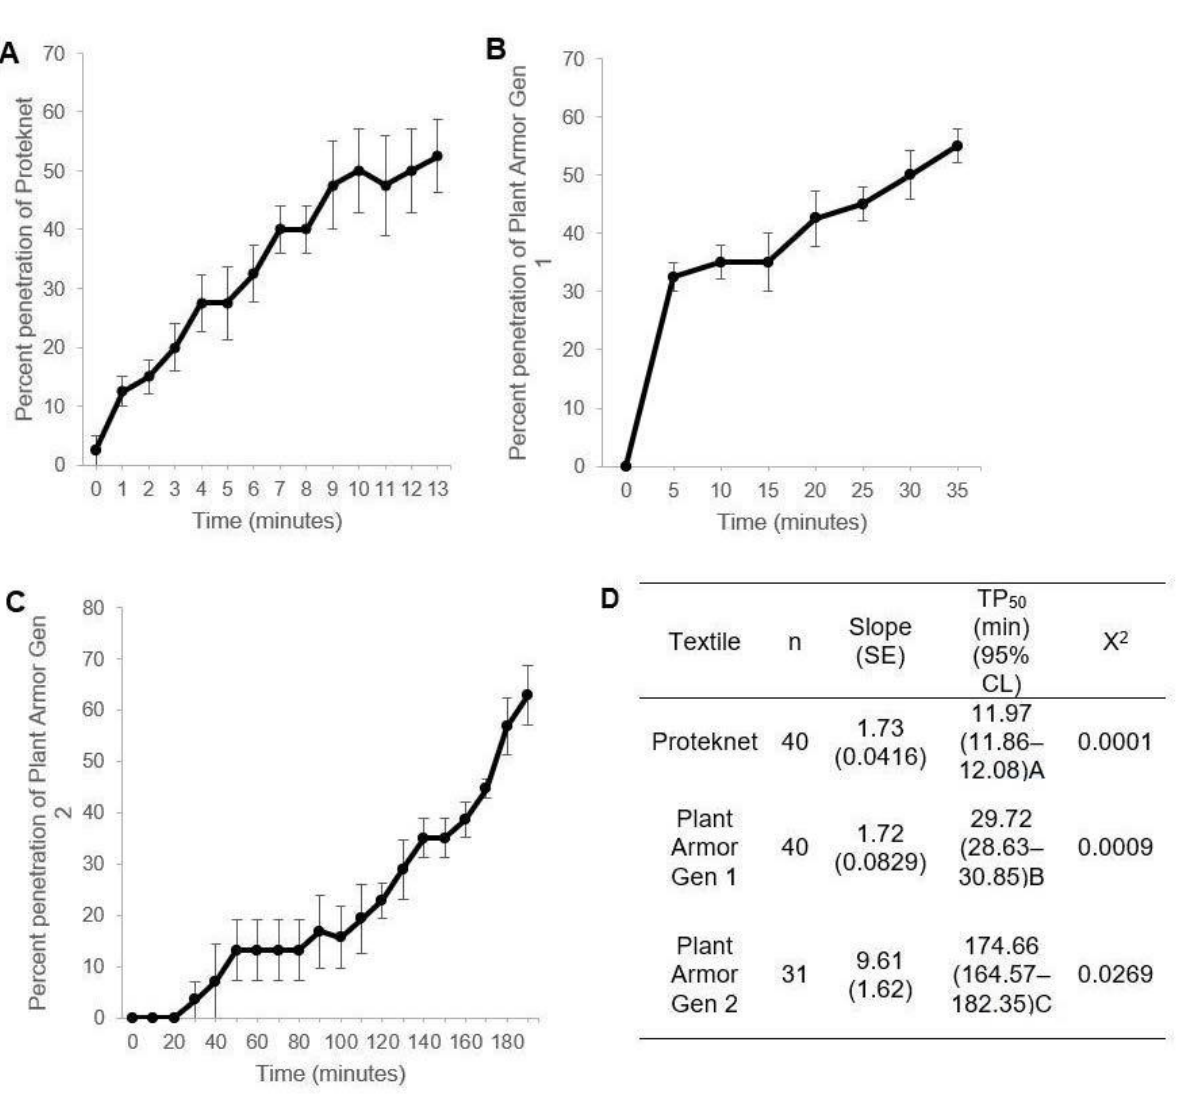
Figure 5. Penetration of unsexed adult thrips, Frankliniella fusca , versus time in the Petri dish bioassay (Figure 1A) for Proteknet ( A ) and Plant Armor Generation (Gen) 1 ( B ) and Gen 2 ( C ). The error bars are ±1 SEM which in some cases were smaller than the size of the symbol and not visible. ( D ) Probit models and time to 50% penetration. TP 50 s followed by different letters were significantly different from the other TP 50 s based on non-overlap of the 95% confidence intervals.